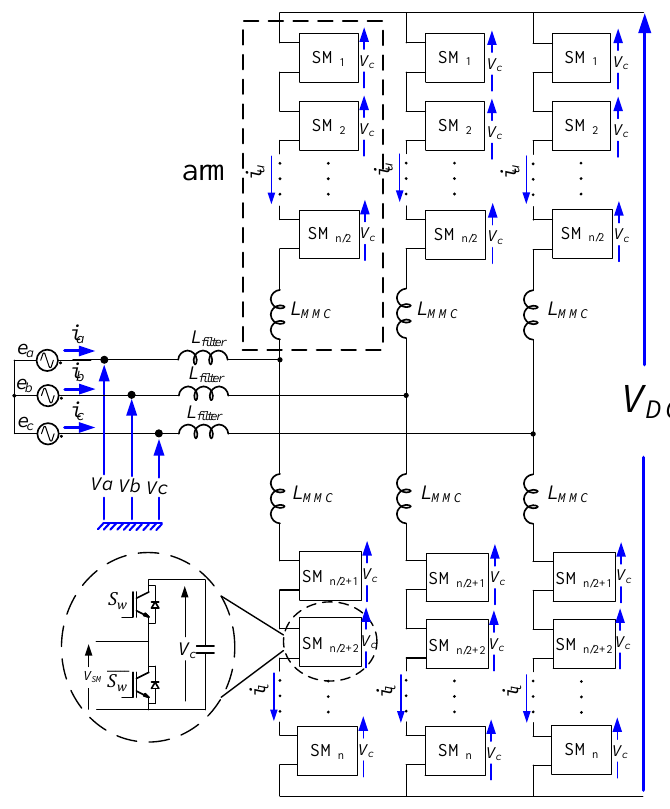
Figure 1. Modular multilevel converter architecture.